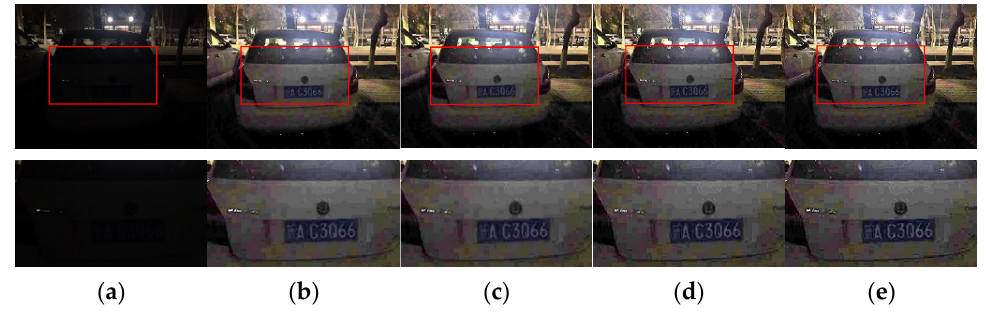
Figure 7. ( a ) Test image and its detail map, ( b ) guided filter refining transmission + dark channel refining result and its detail map, ( c ) AnisGF refining transmission + dark channel refining result and its detail map, ( d ) guided filter refining transmission + dark channel refining + detail enhance- ment result and its detail map, and ( e ) AnisGF refining transmission + dark channel refining + detail enhancement result and its detail map.